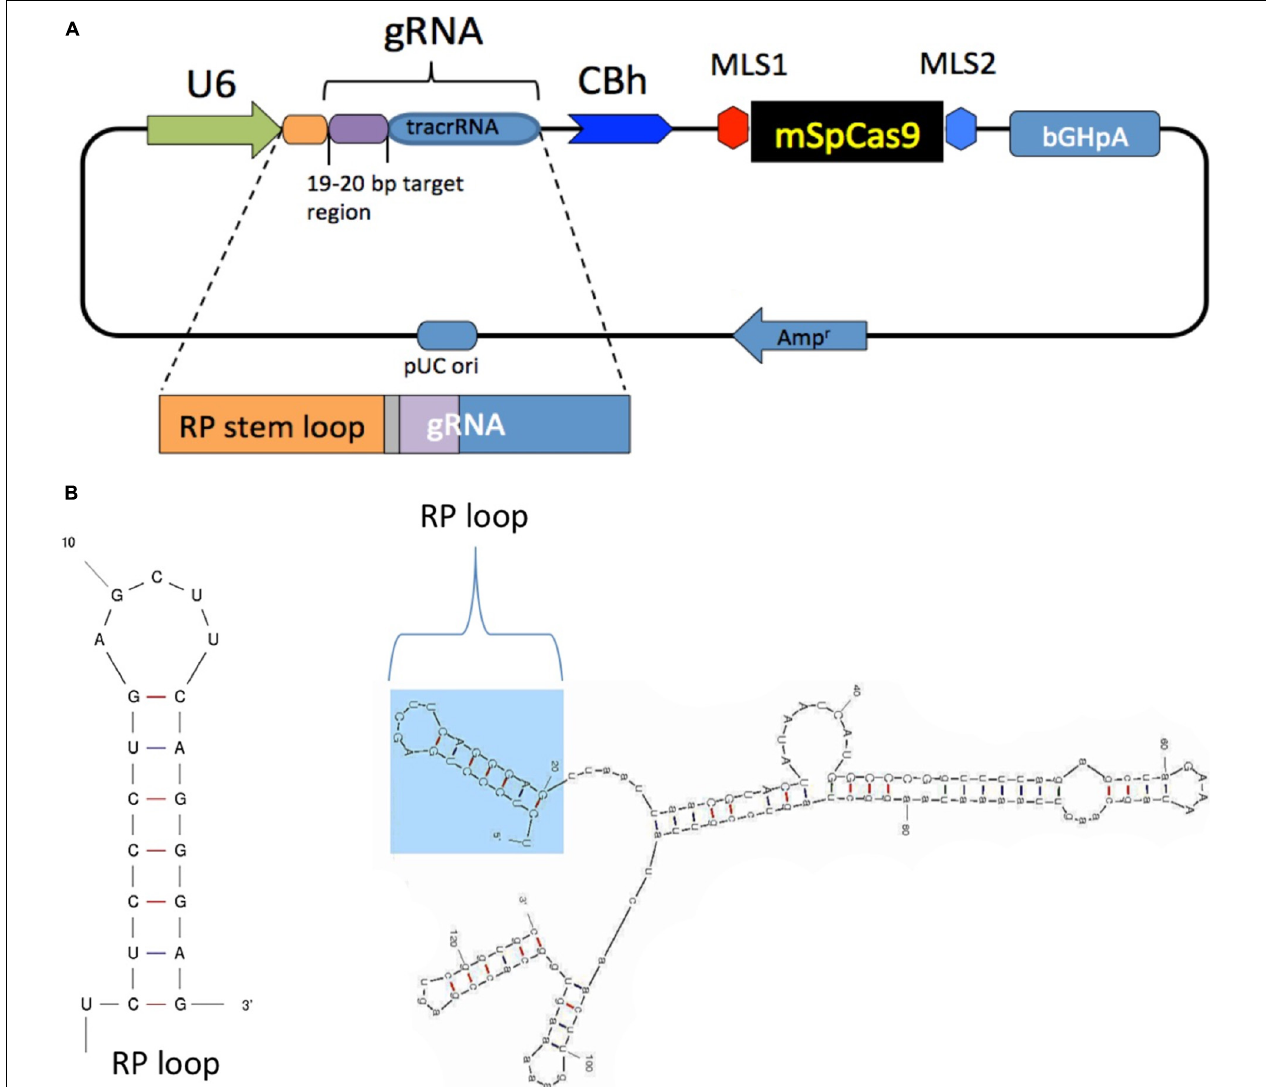
FIGURE 1 | Generation and structure of mitochondria targeting the clustered regularly interspaced short palindromic repeats (CRISPR)– CRISPR -associated protein-9 nuclease (Cas9) complex. (A) Mitochondrial RP loop and guide RNA (gRNA) targeting ND4 is in the downstream of U6 promoter, and chicken beta actin (CBh) controls the expression of mSpCas9 flanked by MLS1 and MLS2 sequences. (B) M-Fold analysis of chimeric gRNA with RP